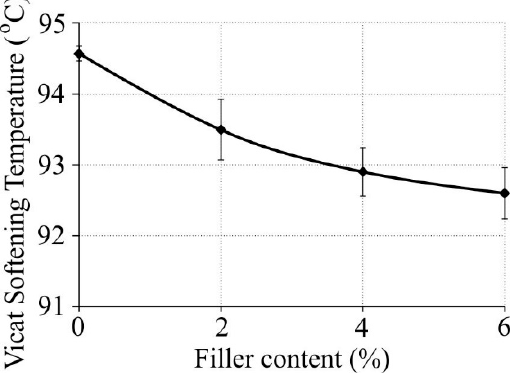
Figure 4. Vicat softening temperature (VST) versus nanofiller mass content in the composite.